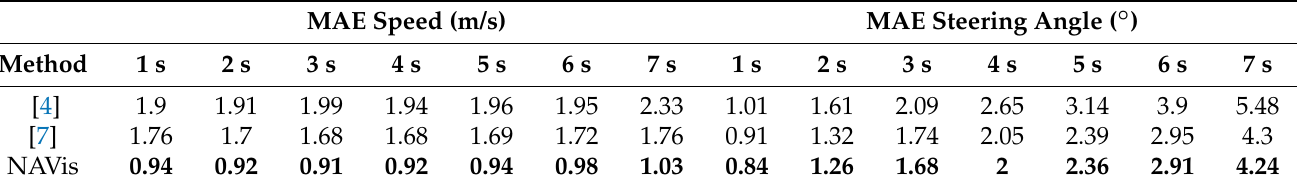
Table 3. Mean errors for speed and steering angle (lower is better). The best performances are shown in